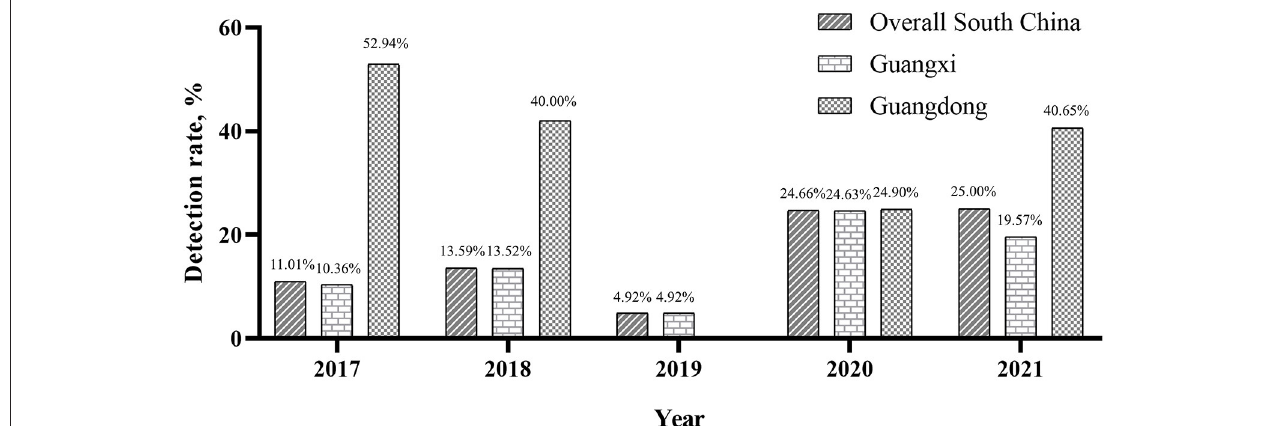
FIGURE 1 | Detection rate of PRRSVs in different regions between 2017 and 2021.